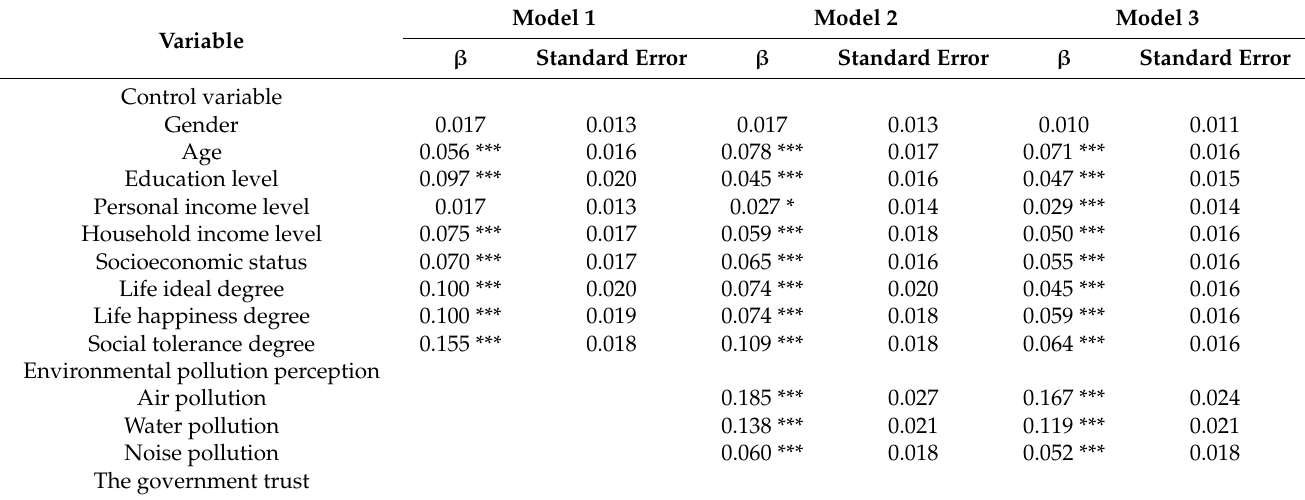
Table 4. Regression results of environmental governance